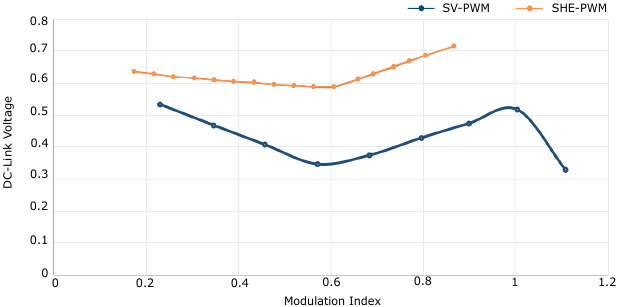
Figure 4. SHE-PWM vs. SV-PWM DC-link requirements at different modulation indexes